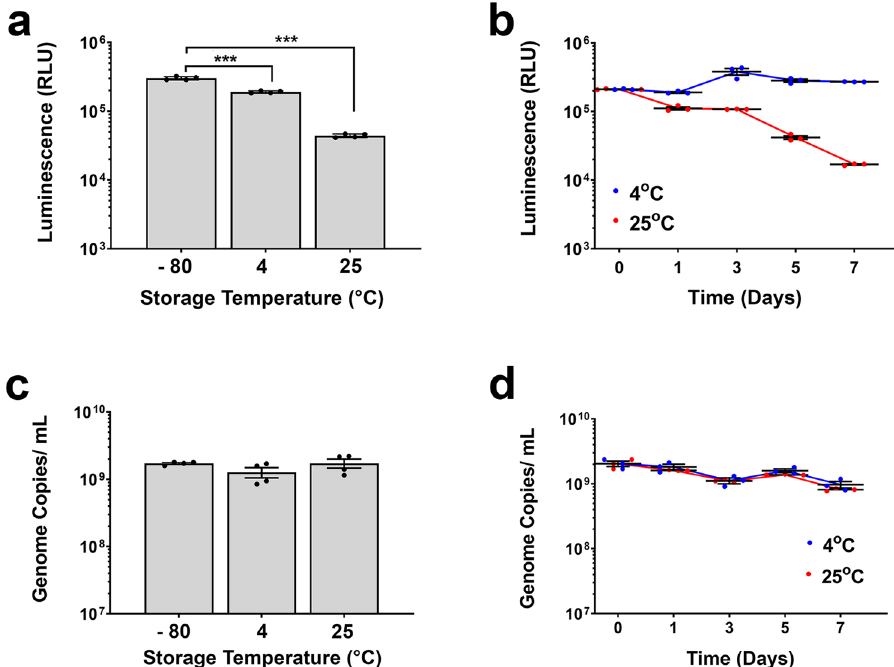
Fig. 1 Stability pro fi le of recombinant AAV for 48 h and 7 days at 4 and 25 °C prior to reformulation in fi lm matrix. AAV expressing the luciferase transgene was placed in Standard Control Formulation (phosphate-buffered saline, 350 mM NaCl, 5% Sorbitol, 0.001% Pluronic F68, pH 7.4). Replicate vials were placed at 4 and 25 °C. Three vials per timepoint were collected and assayed for transgene expression by serial dilution on HeLa RC32 cells and luciferase expression was assessed 72 h after infection (Panels a , b ). DNA from replicate plates of cells were harvested and virus genome copies were assessed by quantitative real-time PCR (Panels c , d ). Data from the vector stored in the same formulation at − 80 °C is included as a point of reference and serves as the comparator for statistical signi fi cance. In all panels, data represents the average ± the standard error of the mean for triple replicates collected at each timepoint. *** p < 0.001, one-way ANOVA with Dunnett ’ s post hoc